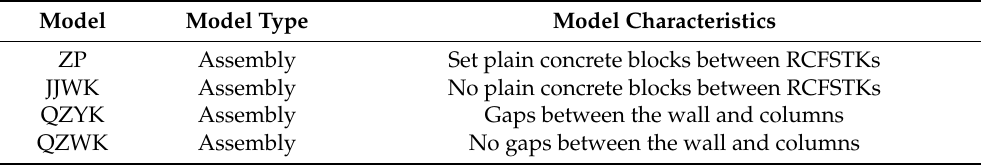
Table 7. Model characteristics.